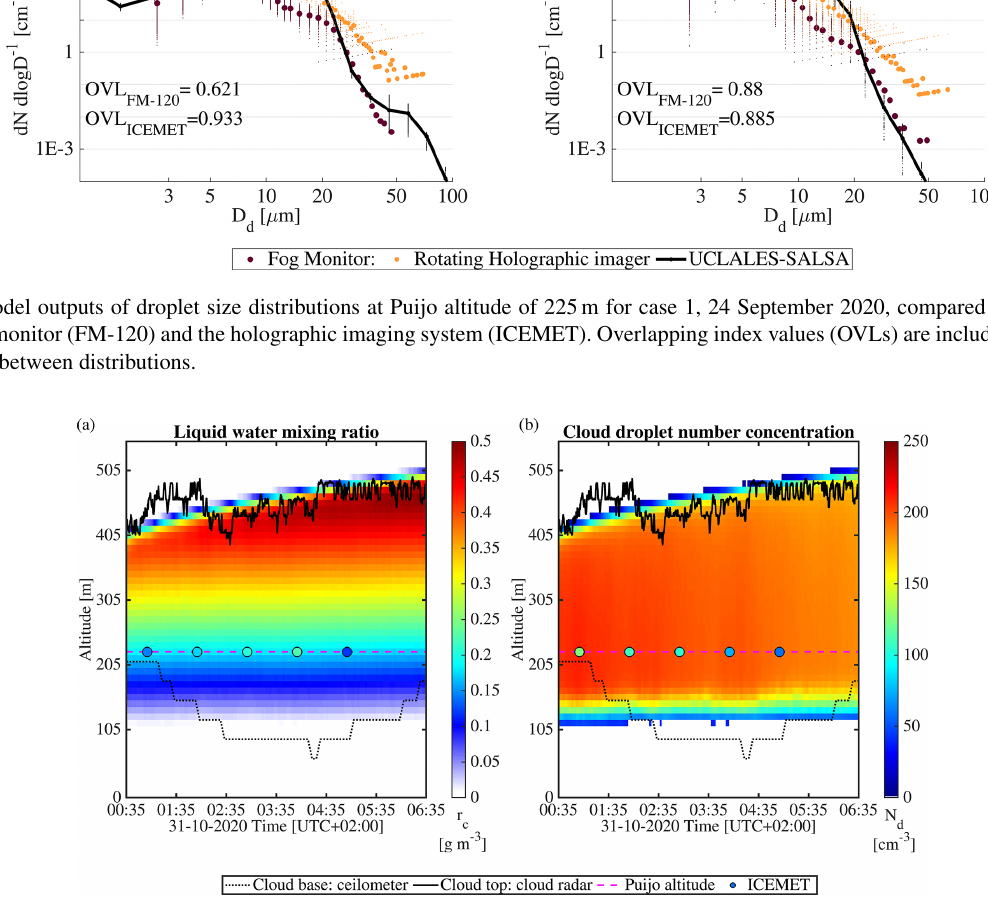
Figure 9. Comparison of cloud boundaries for case 2, 31 October 2020, defined by modelled liquid water content and cloud boundaries retrieved from cloud radar and ceilometer observations, and (a) modelled vertical profile of liquid water content and observations from the holographic imaging system (ICEMET) (b) modelled cloud droplet number concentrations and observations from the holographic imaging system